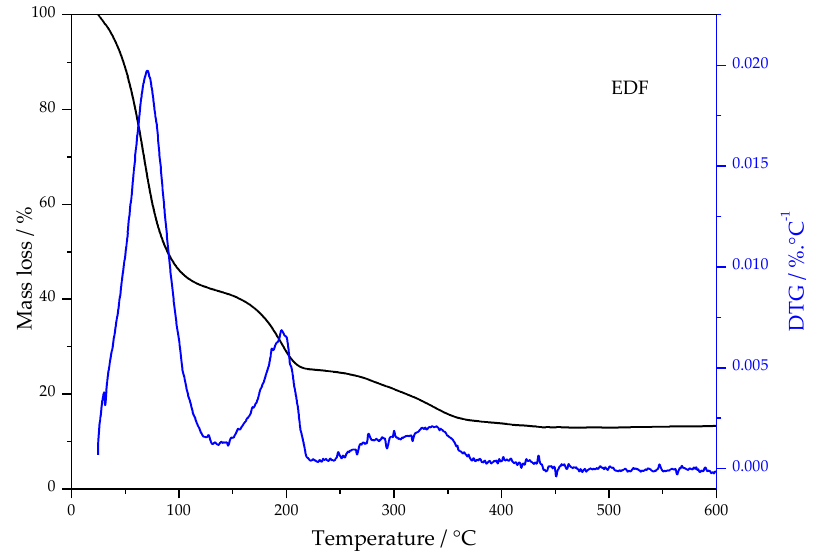
Figure 15. TGA/DTG curves of drilling fluid EDF.